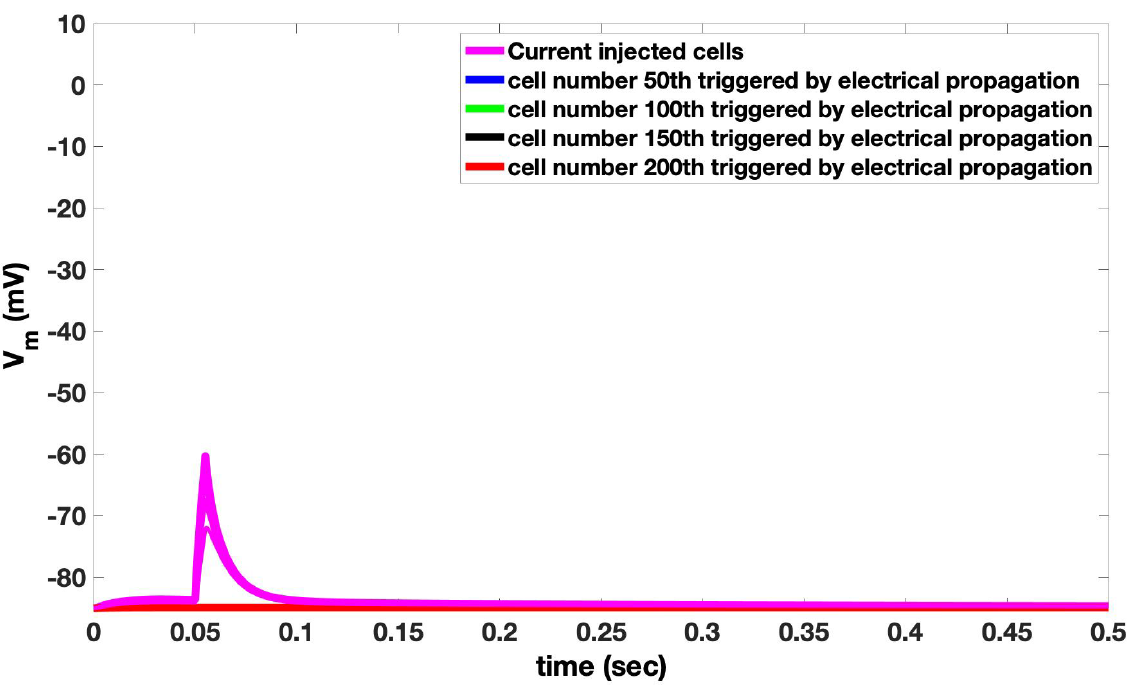
Figure A2. 1-D Simulation with 5 cells fail to produce an action potential that can propagate between cells. Cell numbers 50, 100, 150, and 200 overlap.